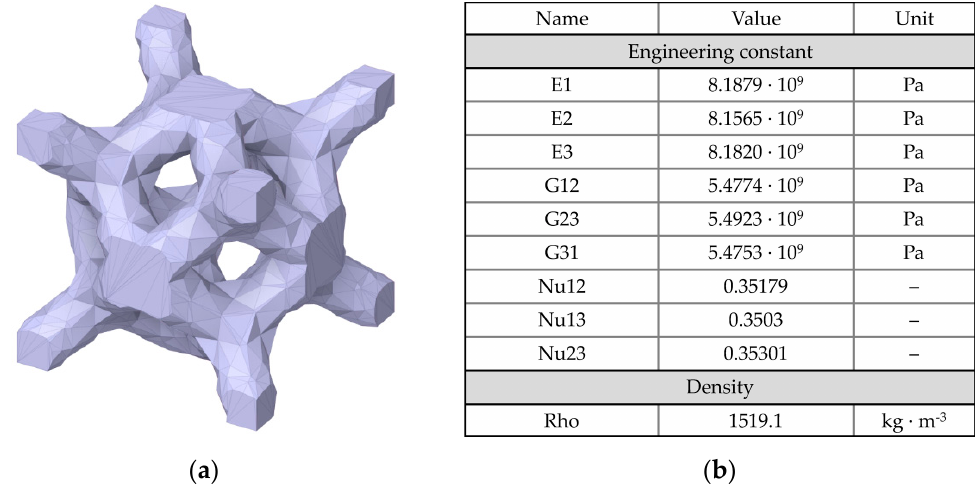
Figure 5. Trabecular titanium: ( a ) unit cell geometry; ( b ) effective characteristics calculated in Material Designer.